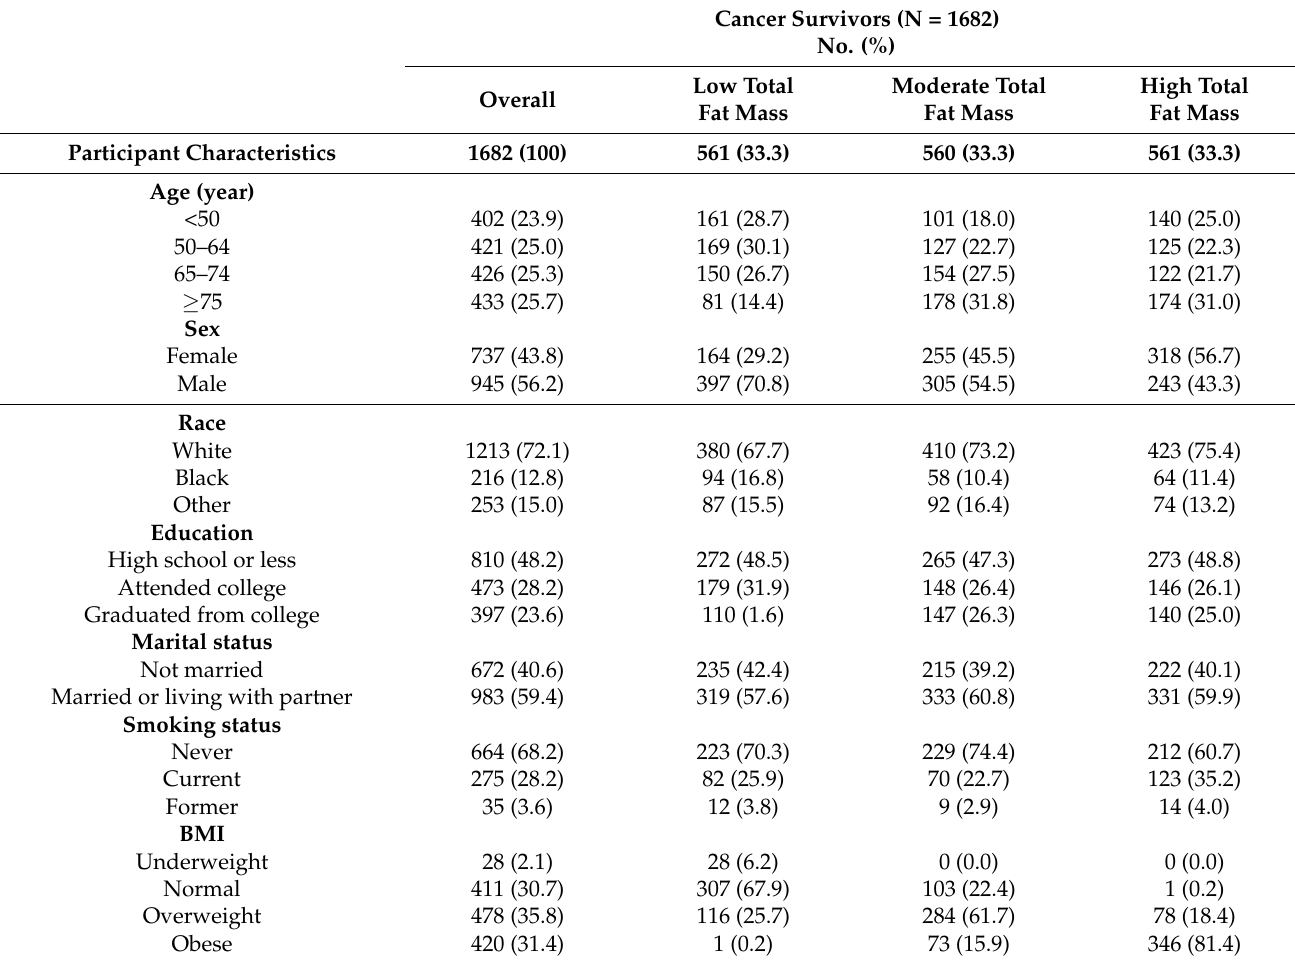
Table 1. Summary of study characteristics, N =